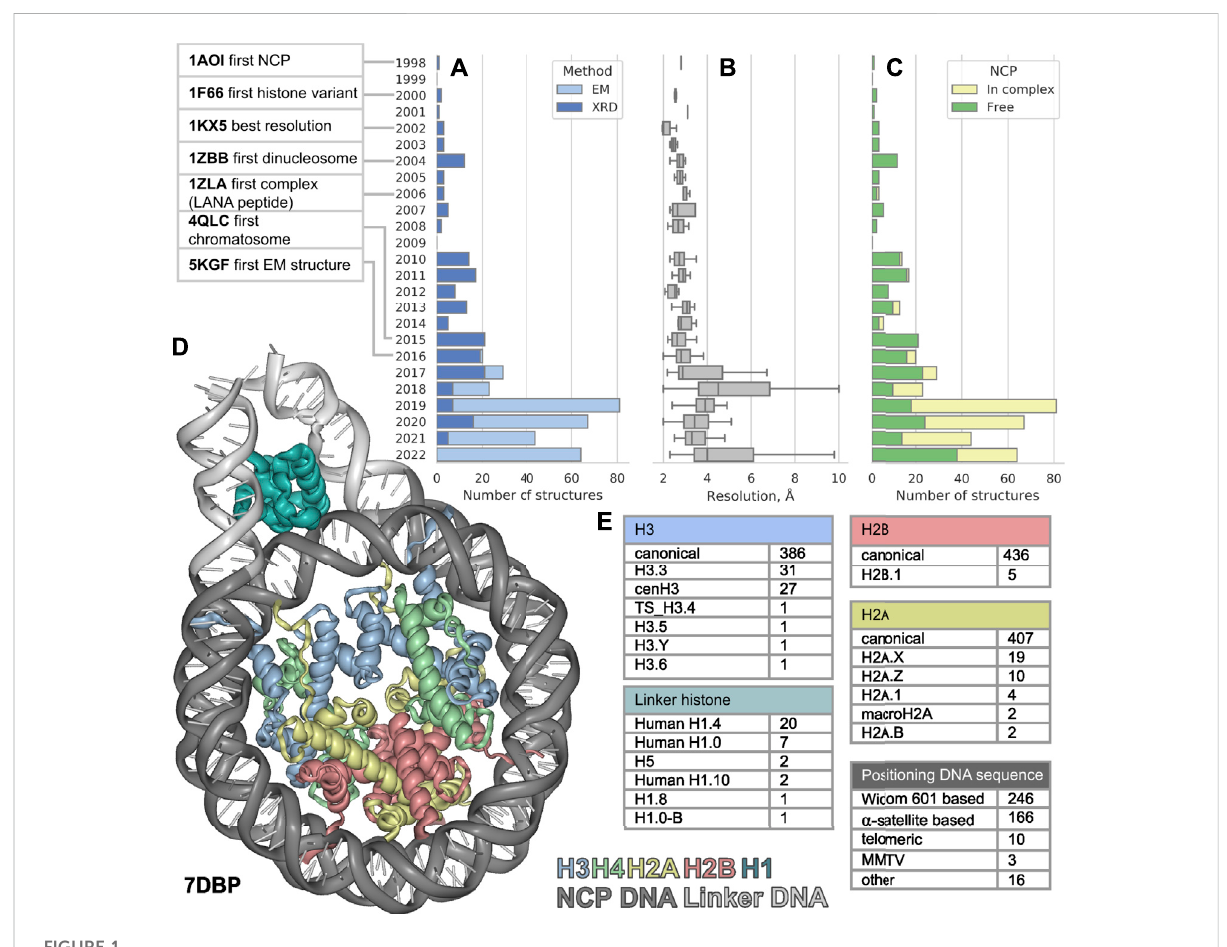
The distribution of nucleosome-containing structures published per year since 1998 (A) subdivided by acquisition method, (B) structure resolution distribution (C) subdivided by type of structure: Free nucleosomes or nucleosomes in complex with non-histone proteins. (D) Visualization of nucleosome in complex with linker histone, linker DNA region is shown in light gray. (E) Variety of nucleosome components among the known structures. The PDB IDs for nucleosome component variants are presented in Supplementary Table